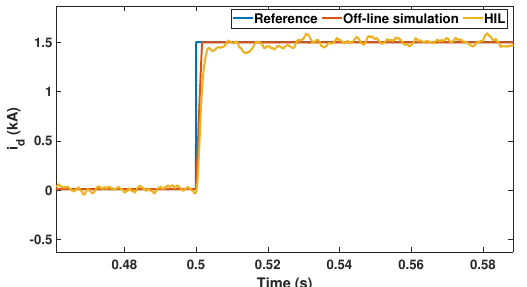
Figure 16. Experimental results of i d using the proposed method subjected to active current